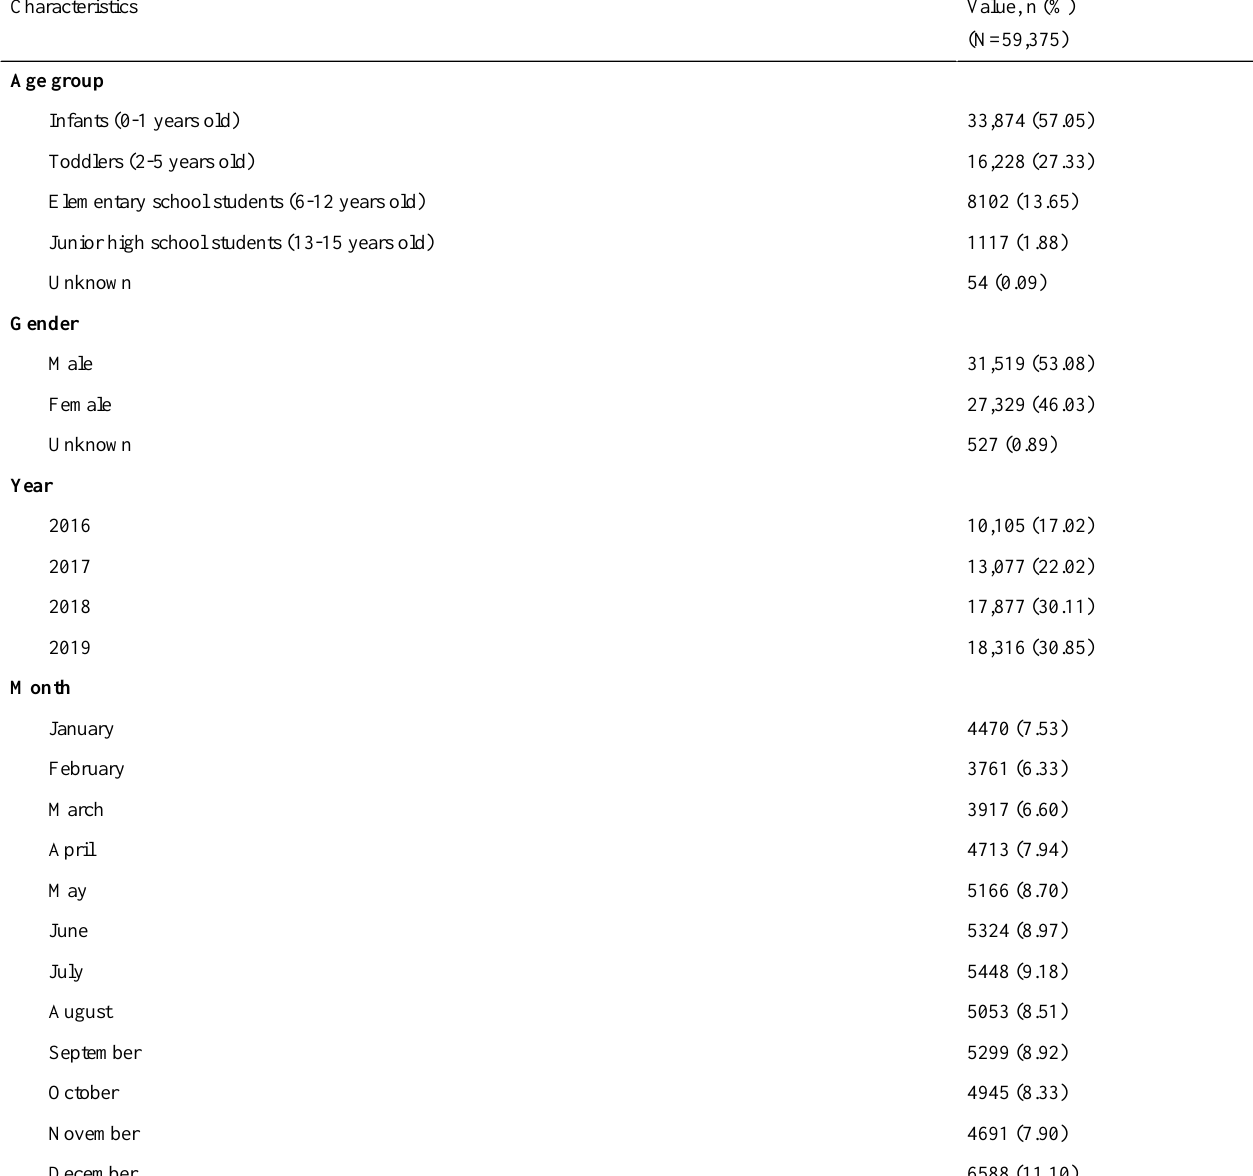
Table 1. Demographic and geographic characteristics of the